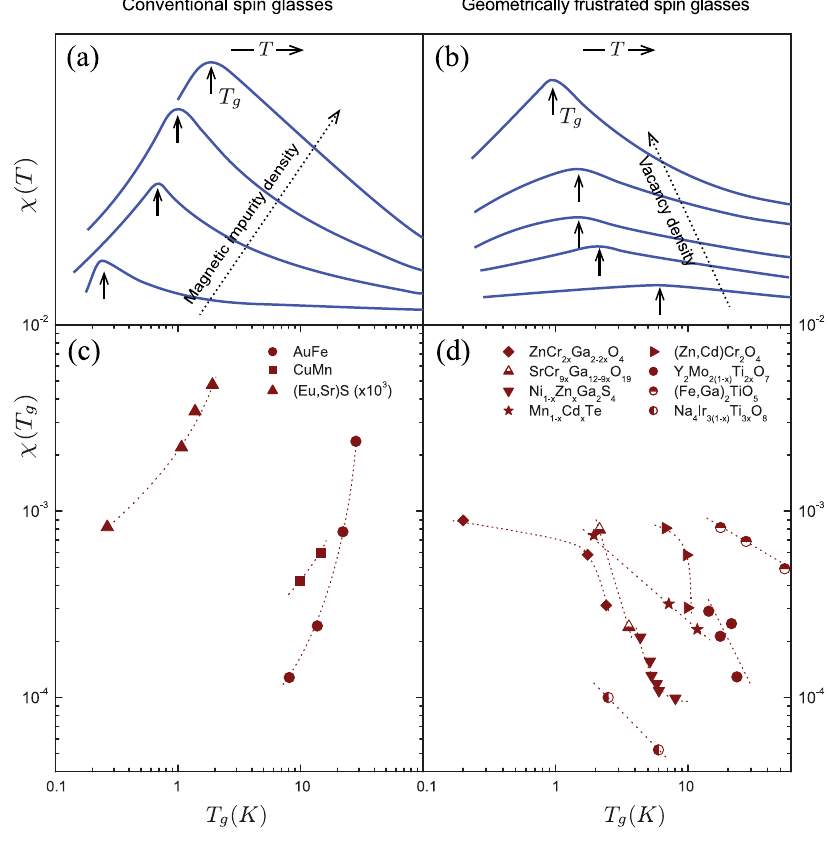
Fig. 1 Behaviour of susceptibilities, χ ( T ) and χ ( T g ) in conventional and geometrically frustrated systems. a , b The susceptibilities χ ( T ) of (Eu,Sr)S 20 and NiGa 2 S 4 21 as a function of temperature for various vacancy concentrations. The lines have been rendered from digitized data in the referenced publications and the T g values are plotted in the lower panels. c , d The susceptibilities χ ( T g ) at T g vs. T g for conventional 22,23 and frustrated spin glasses. The reference sources for the GF data are provided in Table 1.